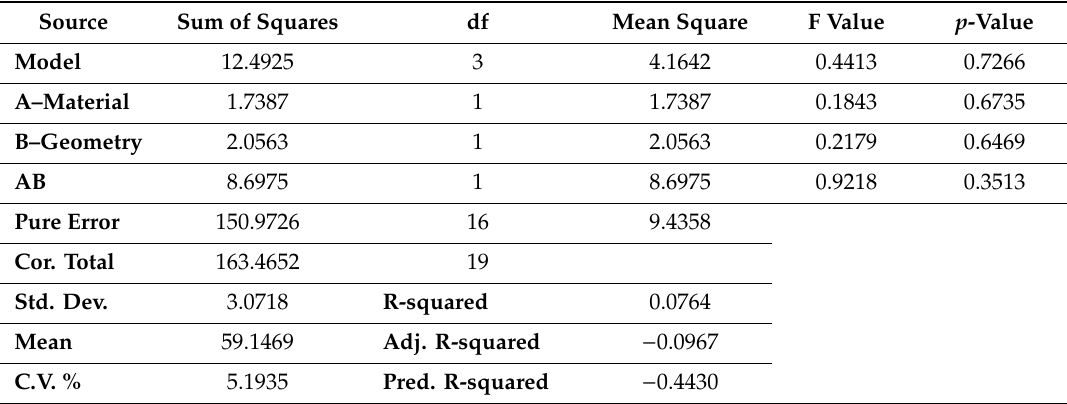
Figure 8. E ff ects diagram for tensile test. Figure 8. Effects diagram for tensile test. Table 4. ANOVA table for tensile test (response: Table 3. ANOVA table for tensile test (response is Young’s modulus).